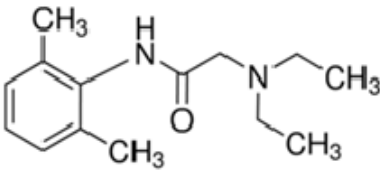
Figure 1. Chemical structure of lidocaine. Table 1. Acceptable maximum dosages of commonly used local anesthetics